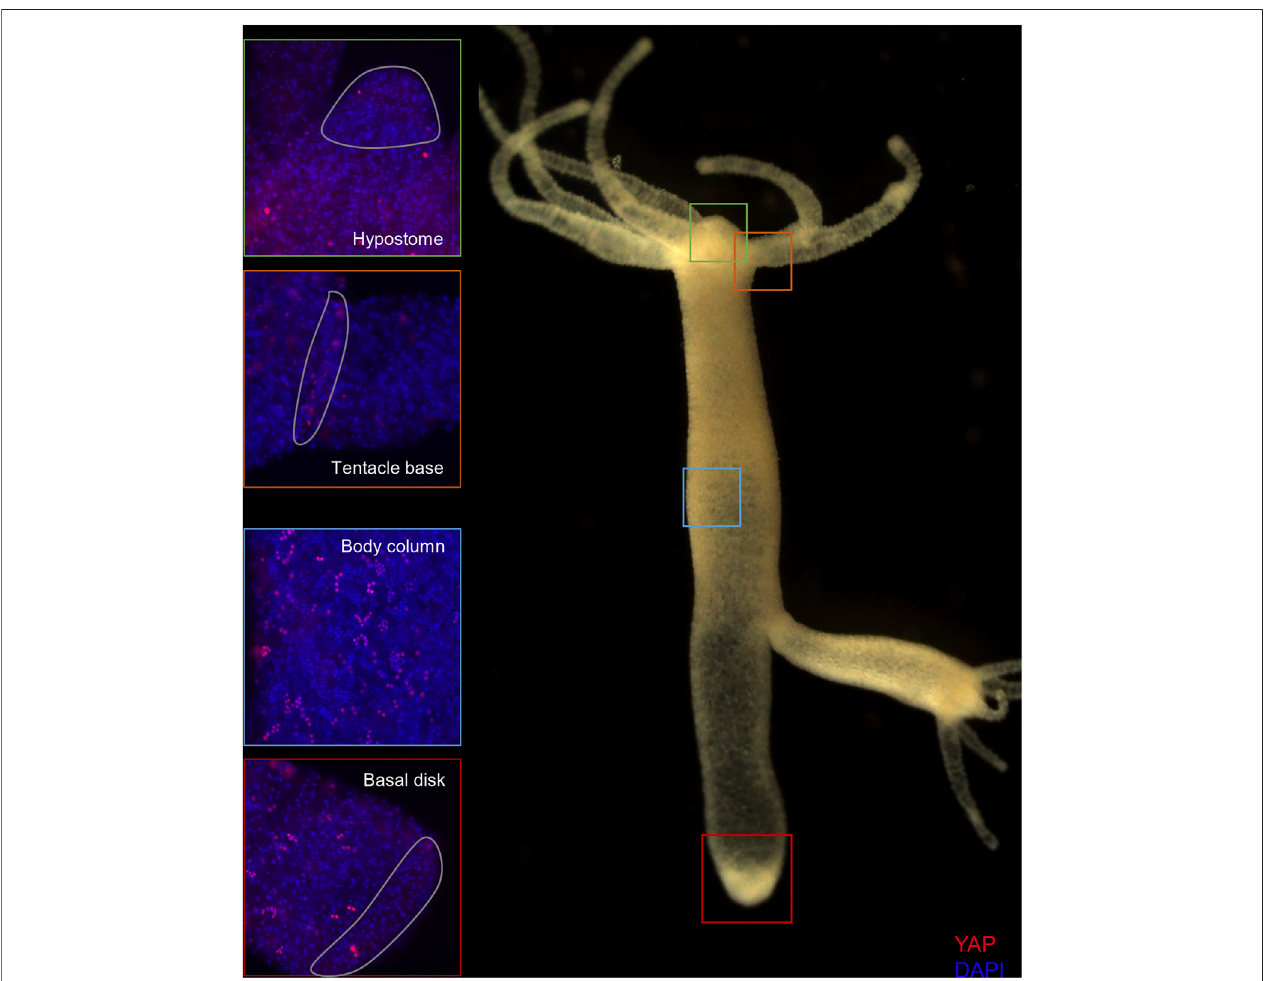
FIGURE5| Expressionof Hvul _YAPin Hydra .Immuno fl uorescenceassayof Hvul _YAPperformedusinganti-CheYkiantibodyshowinglocalizationofYAPpositive cells at various locations in an adult polyp. The red fl uorescent dye shows Alexa 594 staining of YAP and the blue dye shows DAPI staining of nucleus. The hypostomal region is indicated by a green box, the tentacle base is indicated by an orange box. The body column is indicated by a blue box and basal disc area is indicated by a red box. ( N (cid:2) 3).